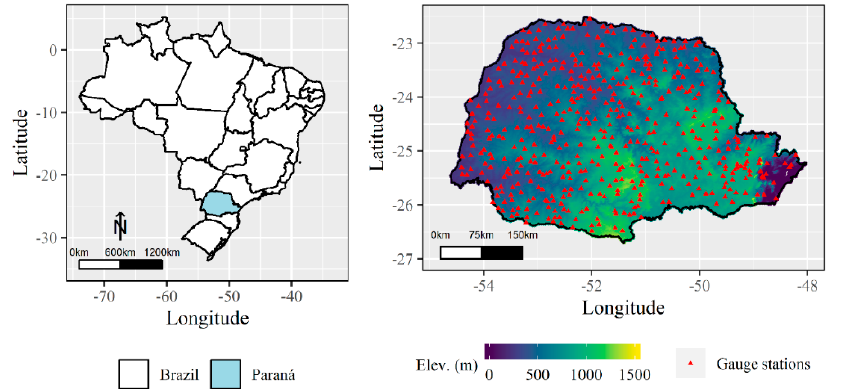
Figure 1. Study area and gauges used to validate the Integrated Multi-satellite Retrievals for GPM (IMERG) estimates of precipitation at daily and monthly time-steps.